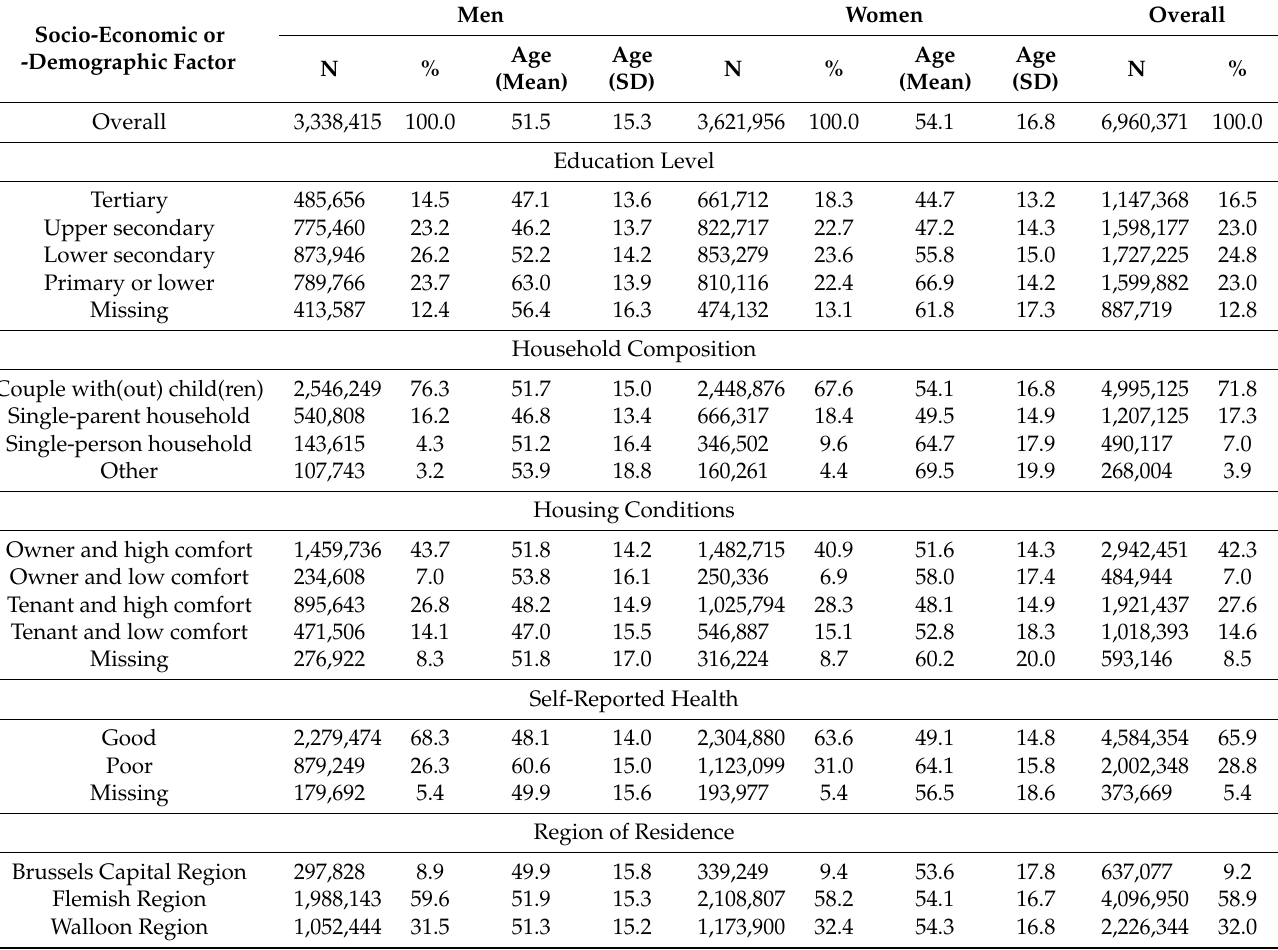
Table 1. Socio-economic and -demographic characteristics of the study population at baseline (1 January 2004), based on census 2001